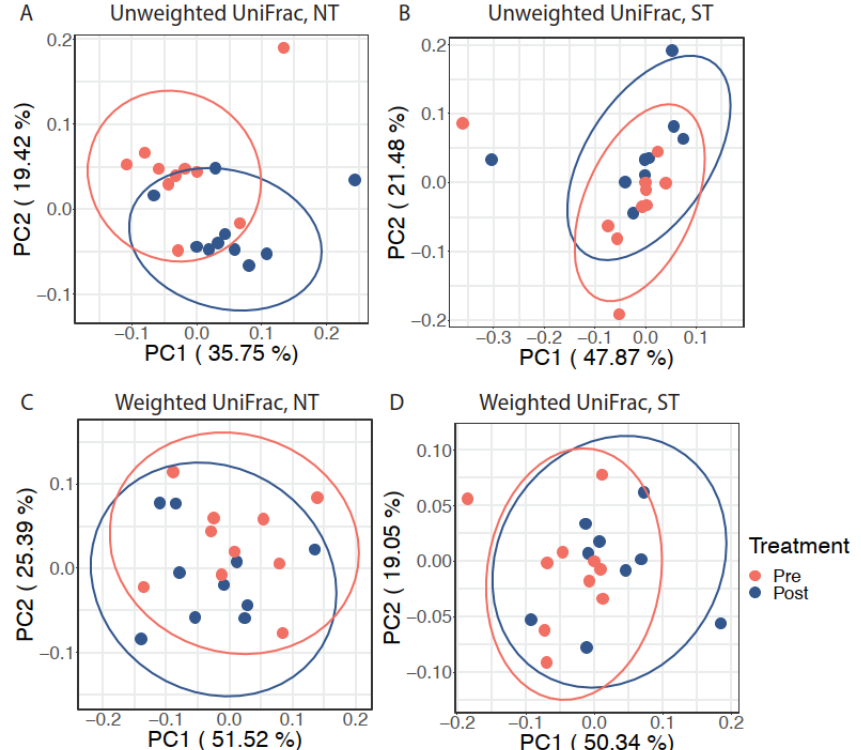
Figure 3. The effect of CPE oral rinse on the oral microbiota with inter-individual variation adjustment. Adjusted principal coordinates analysis (aPCoA) plots on ( A ) unweighted UniFrac distance in NT subjects, ( B ) unweighted UniFrac distance in ST subjects, ( C ) weighted UniFrac distance in NT subjects, and ( D ) weighted UniFrac distance in ST subjects. Ellipses represent 95% confidence intervals.